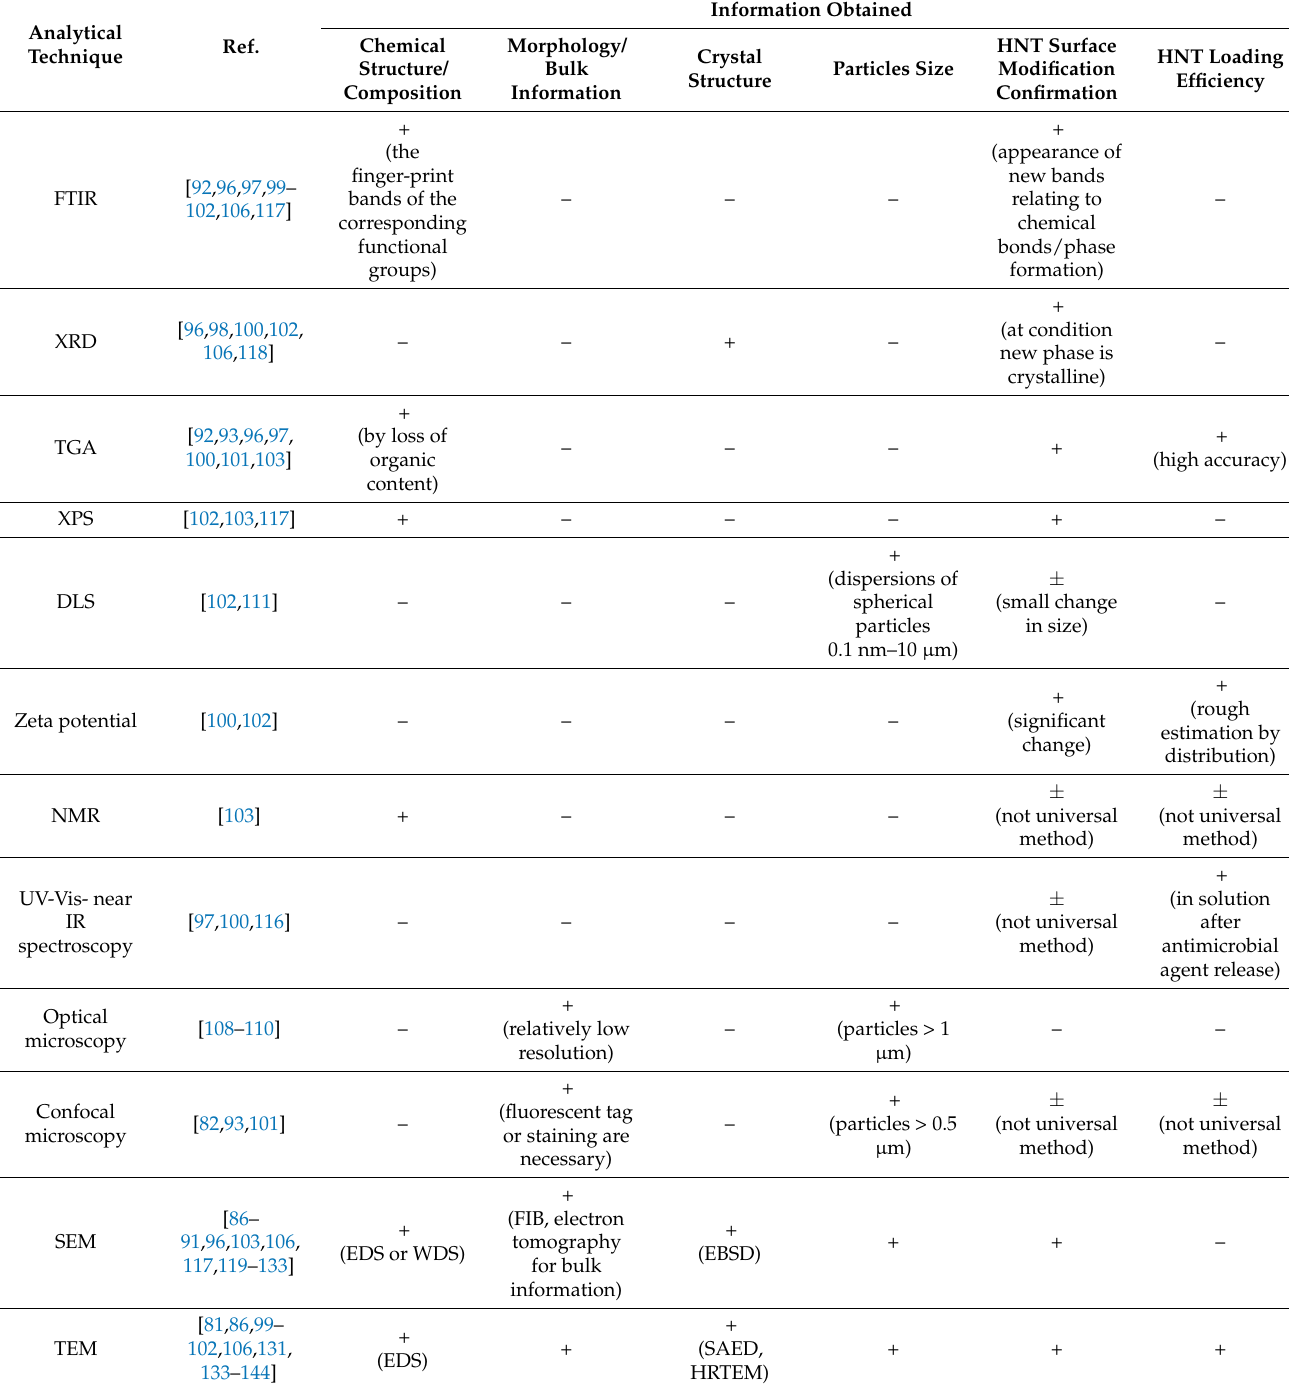
Table 1. Comparison of analytical techniques employed for biopolymer/halloysite nanotube (HNT) composite analysis (“+” means that the method is suitable for determination of a given characteristic of biopolymer/HNT composite, “ ± ” means that the method is of limited suitability and “–” means that the method is